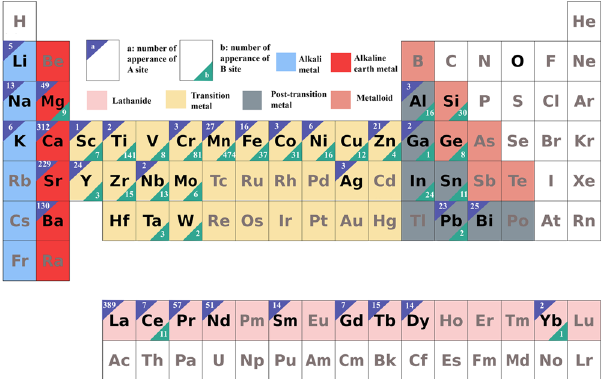
Fig. 2 The chemical space of the database. The background colors indicate different subcategories and numbers exhibit the appearance frequency of different elements in A or B